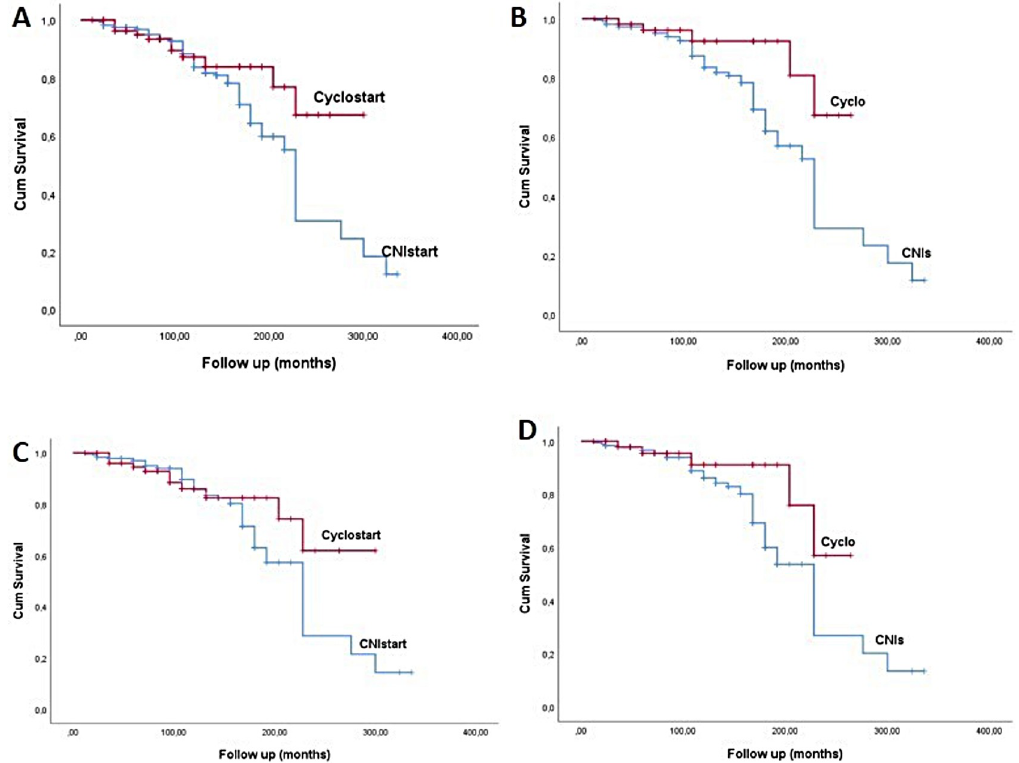
Fig 2. Differences in Renal Survival, defined as total or partial remission, between CNIstart and Cyclostart groups (whole cohort and presence of nephrotic syndrome) (A, C respectively) and patients who received CNIs or Cyclo only (whole cohort and presence of nephrotic syndrome) (B, D respectively).